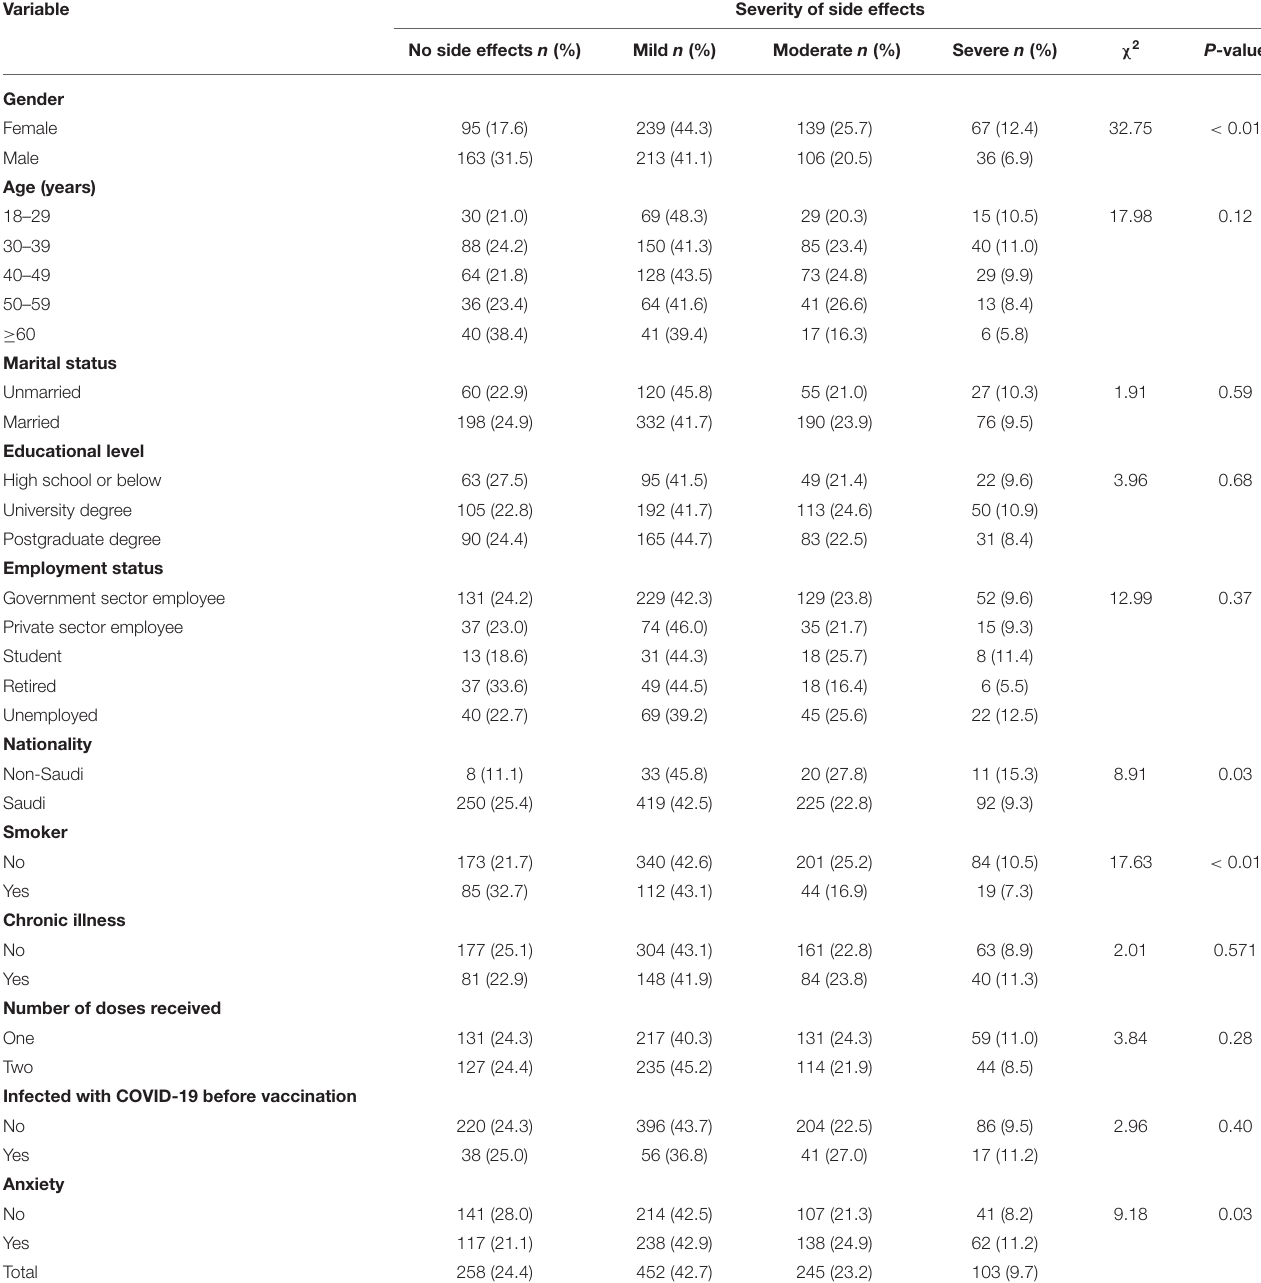
TABLE 4 | Participants’ experience and severity of side effects by sociodemographic and health characteristics.